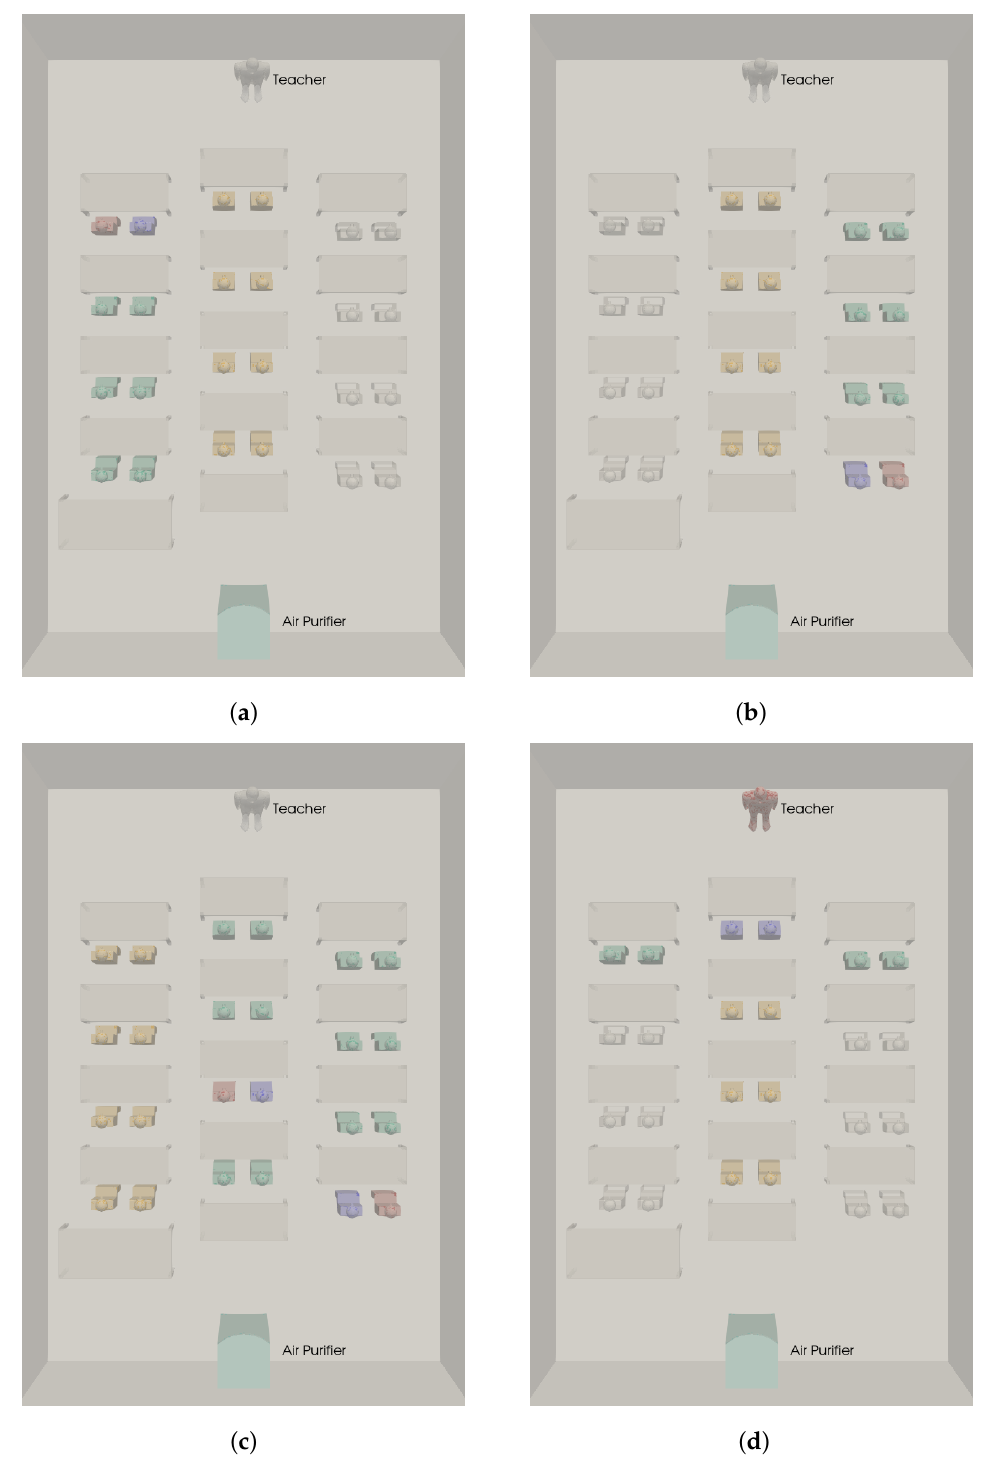
Figure 2. Sketches of the four considered scenarios: ( a ) Scenario 1 ( b ) Scenario 2 ( c ) Scenario 3 ( d ) Scenario 4. The person in red is the index patient and the color purple denotes the student adjacent to the index patient. Green color denotes the students in the same row as the index patient and yellow color denotes the students in the adjacent